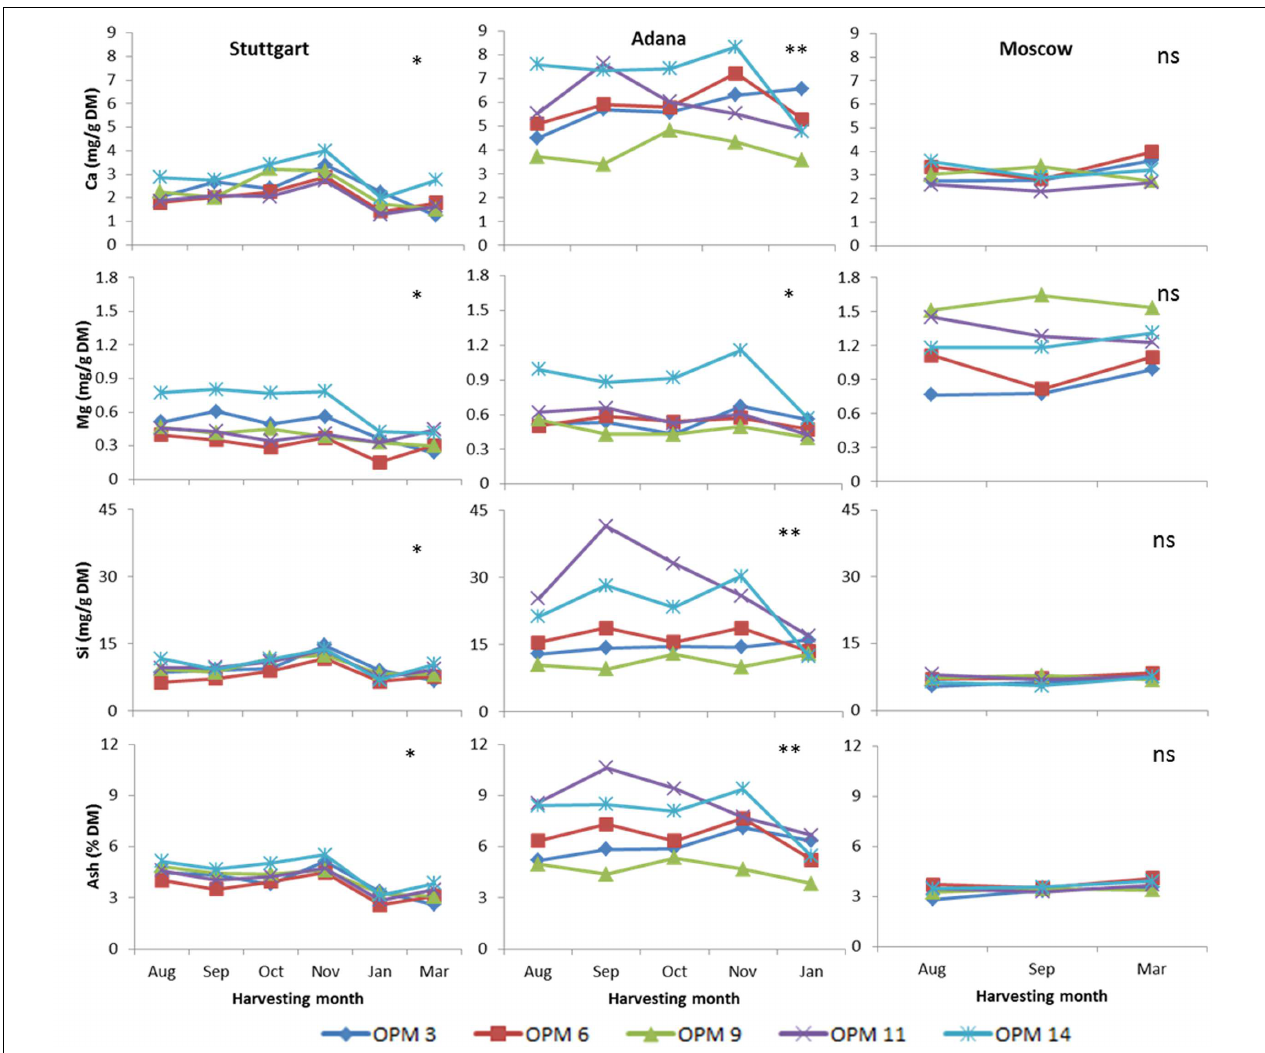
FIGURE 3 | Ash content and major ash-forming elements for each harvesting time, genotype, and site. Single asterisks ( ∗ ) indicate a significant impact ( P = 0.05) of interaction between harvesting time, genotype, and site. Double asterisks ( ∗∗ ) refer to a highly significant impact and “ns” indicates that the effect was not